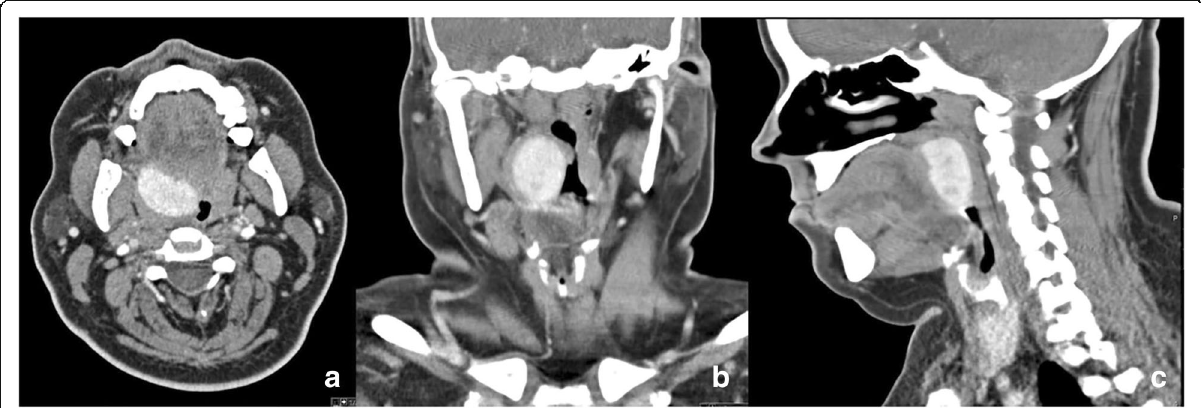
Fig. 7 SFT of the right palatine tonsil. Enhanced CT images ( a – c ) showing a well- defined homogeneous enhancing mass at the right palatine tonsil. No adenopathy is present